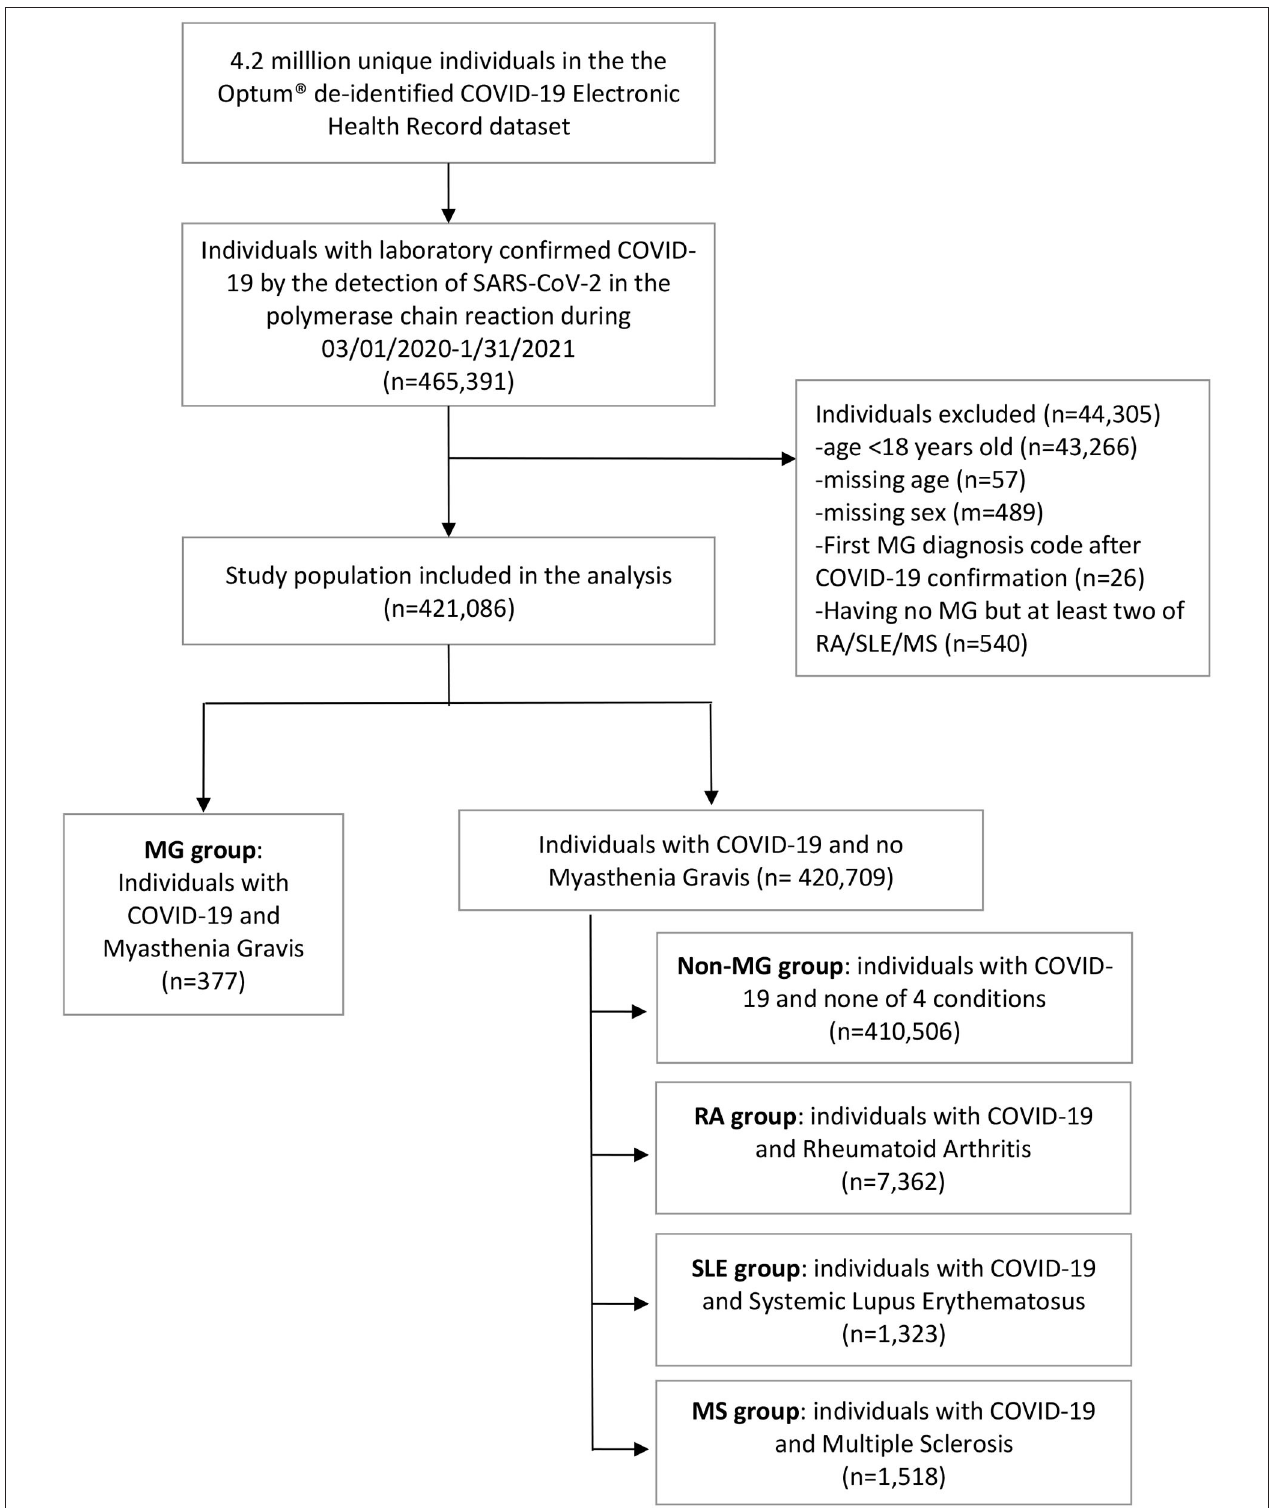
FIGURE 1 | Cohort